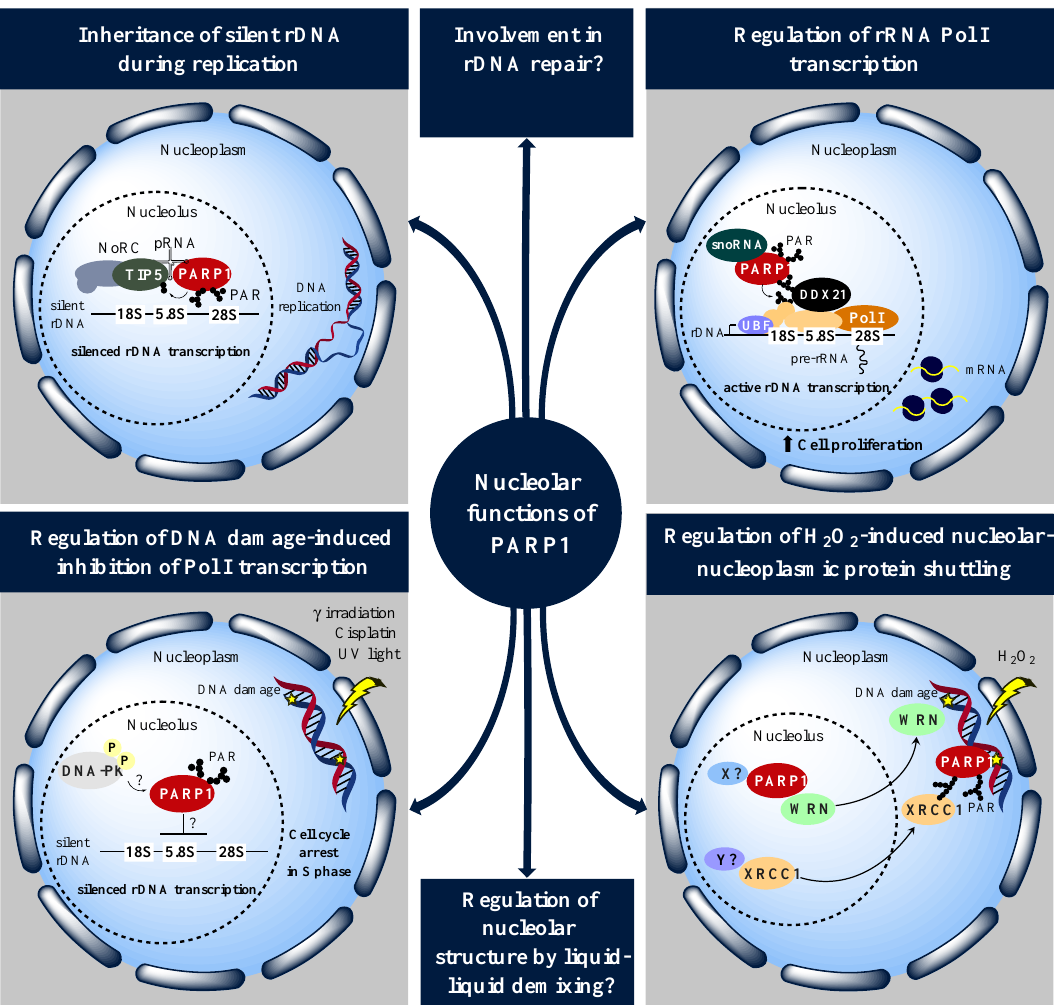
Figure 1. Functional roles of PARP1 in nucleolar biology. DDX21, DEAD-box helicase 21; DNA-PK, DNA-dependent protein kinase; NoRC, nucleolar remodeling complex; PAR, poly(ADP-ribose); PARP1, poly(ADP-ribosyl) polymerase 1; Pol I, polymerase I; pRNA, promotor-associated RNA; rDNA, ribosomal DNA; rRNA, ribosomal RNA; snoRNA, small nucleolar RNA; TIP5, TTF-1-interacting protein 5; UBF, upstream binding factor; WRN, Werner syndrome protein; XRCC1, X-ray repair cross complementing 1. For details see Section